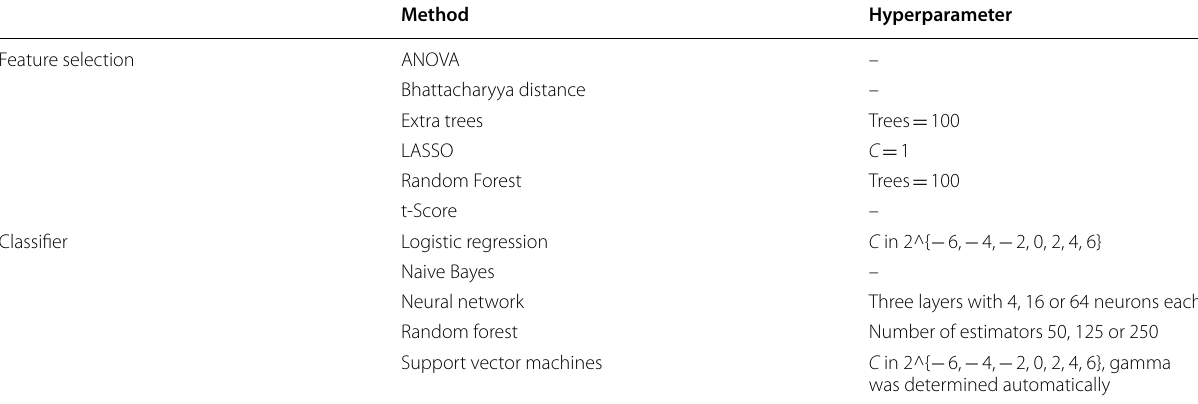
C denotes a hyperparameter regarding the regularization; higher C will make the model fit to the data more